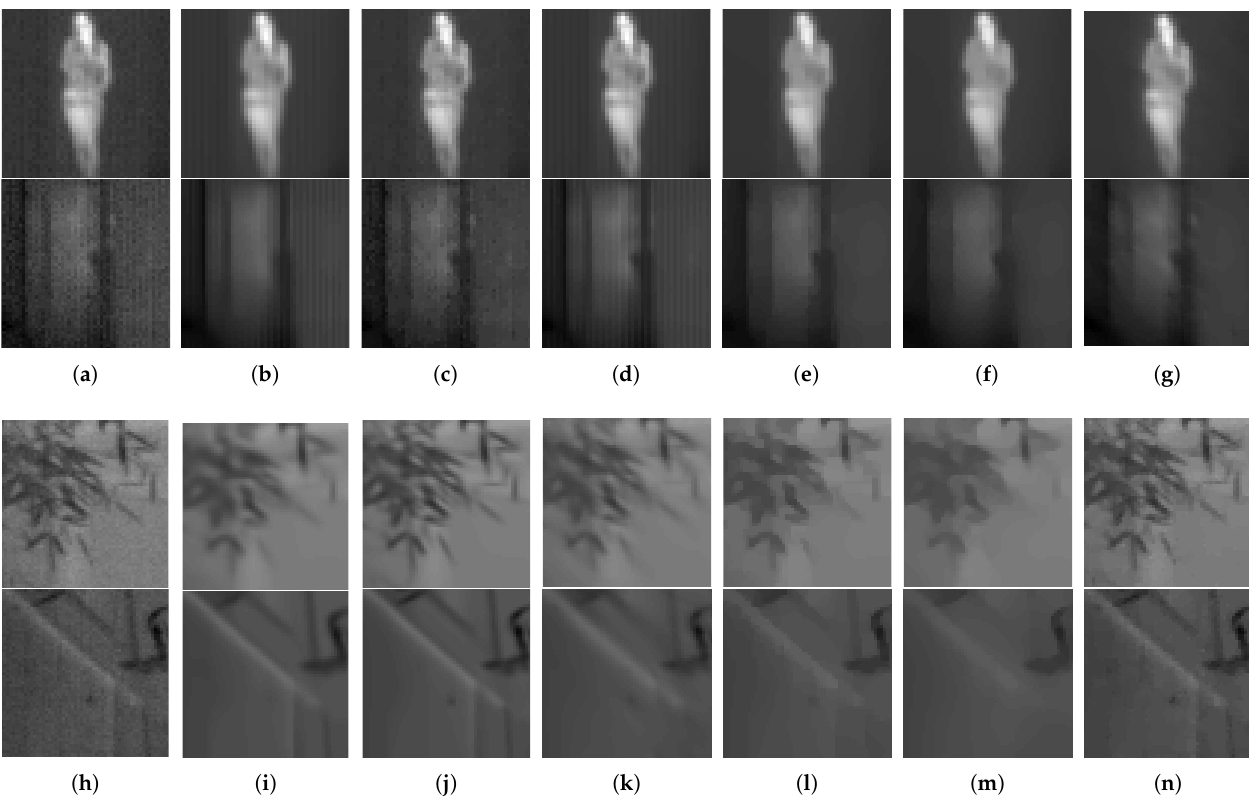
Table 4: Thermal image denoising using synthesized images with the four regulariza- tion strategies. Performances of each regularizer have been measured by four image assessments: PSNR and SSIM.